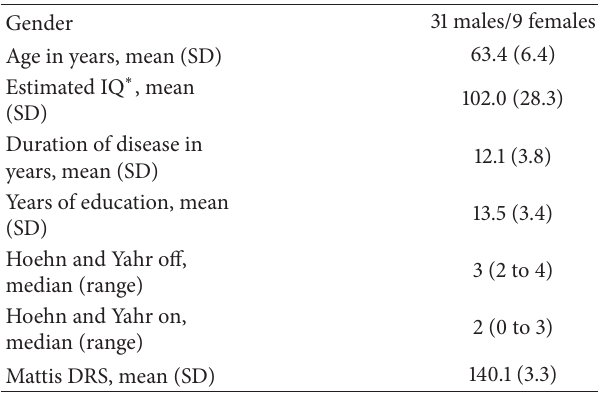
Table 1: Demographic and clinical